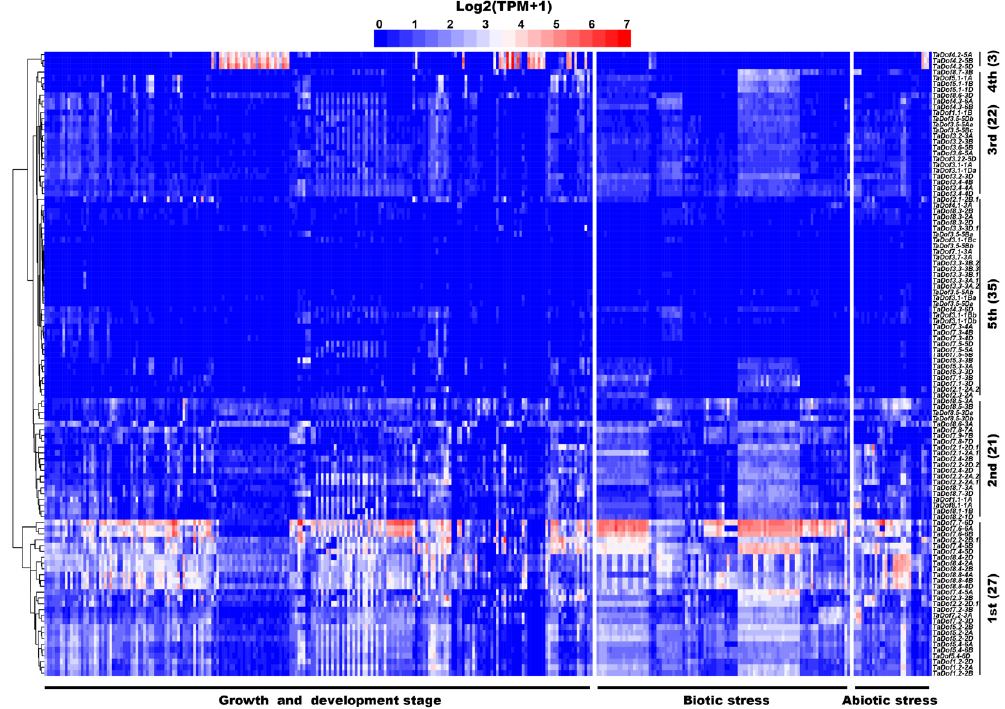
Figure 6. Expression pattern profiling of TaDofs using large-scale transcriptome data. Depth of the color represents the level of gene expression. Log2(TPM + 1) was used to scale the expression levels of TaDofs. TaDofs were divided into five groups (1st, 2nd, 3rd, 4th, and 5th) according expression